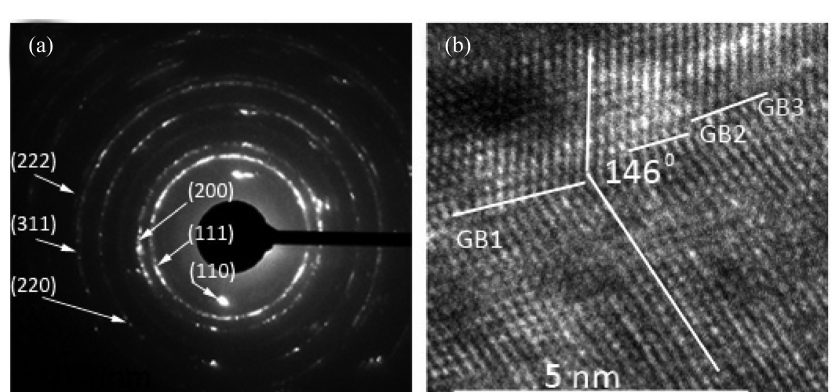
Figure 7: DSC trace of Ni20Cr micro-wires with engineering strain of 46.6%, at a constant heating rate of